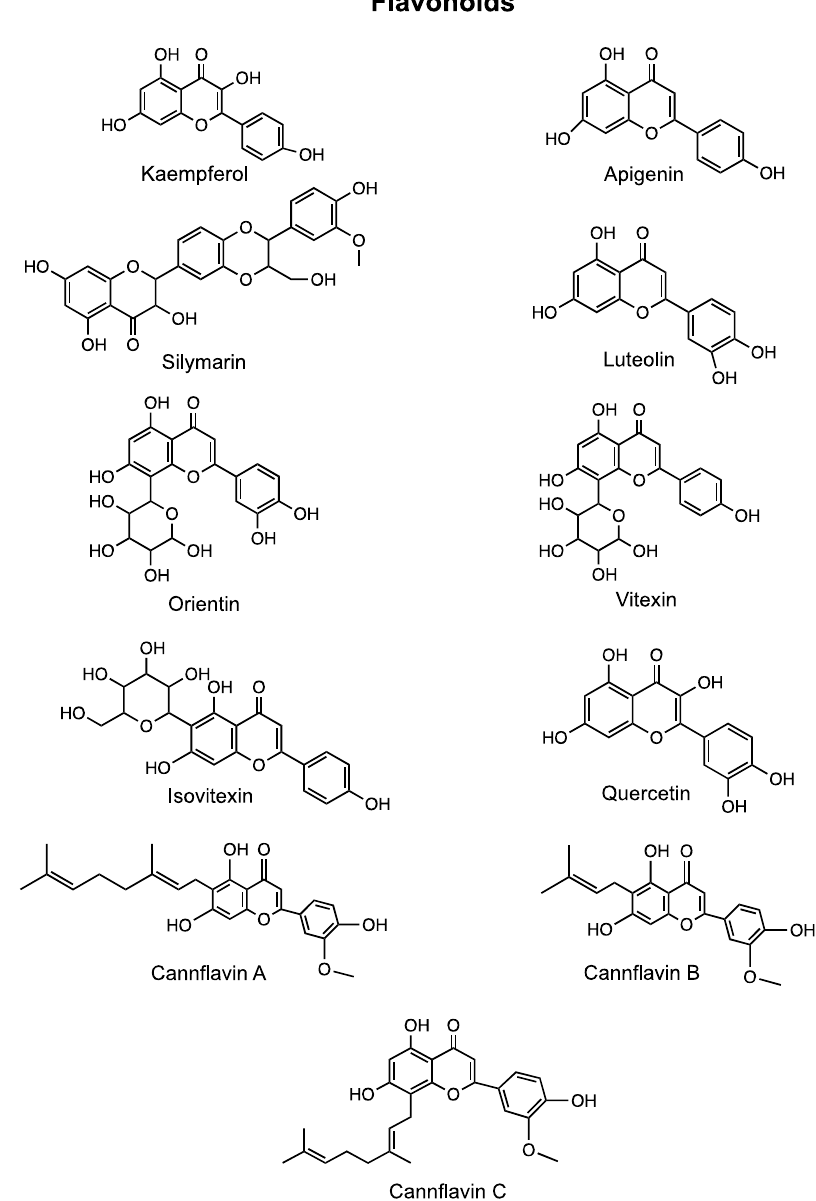
Figure 3. Structure of various flavonoids found in the Cannabis